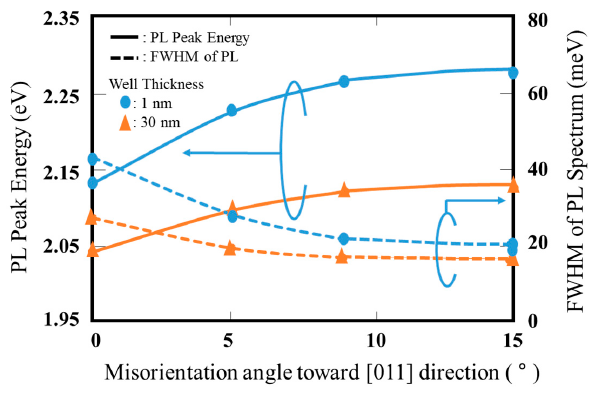
Figure 7. Relationship between PL peak energy and FWHM of PL spectrum as function of misorientation angle toward [011] direction.